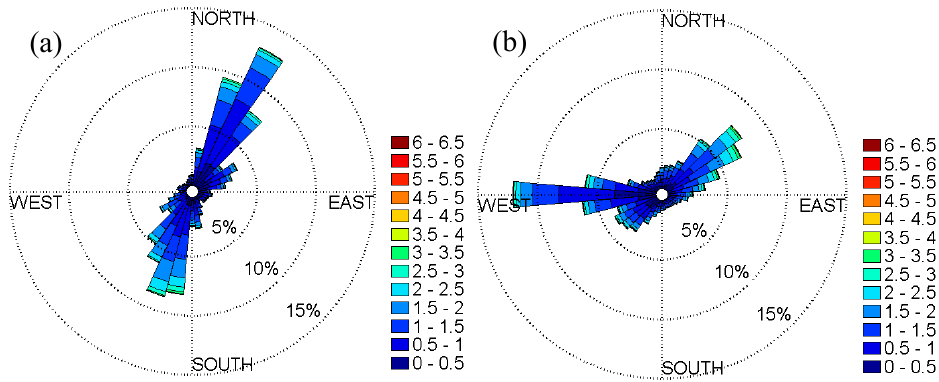
Figure 6. The wave roses of observed data ( a ) and modelled data ( b ). The color bar indicates the value range of H s .